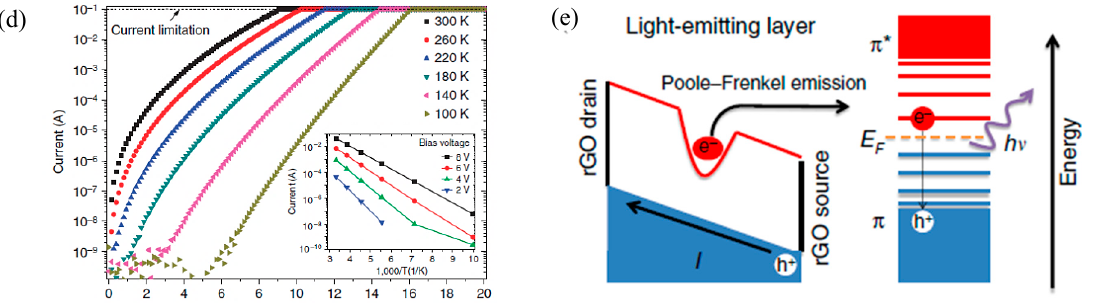
Figure 11. ( a ) The schematic of GFLED, the interfacing layer with semi-reduced GO (blue) between GO (orange) rGO (yellow) is responsible for the light emission from GFLED, ( b ) shows a histogram for the distribution of EL versus fixed voltage and current values, ( c ) EL response of GFLED under gate voltage from 5 to 50 V. ( d ) The voltage biasing response of GFLED verses source to drain current at different temperature conditions, ( e ) illustration of the Poole-Frenkel emission, the excitation of a trapped electron in unoccupied lowest energy state and the excitation of electron combination with p band holes for the photon emissions [63].